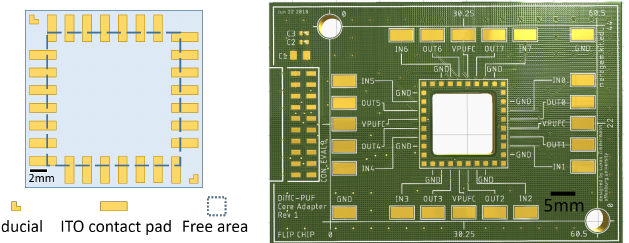
Figure 14. Schematic drawing of the ITO-coated glass and adapter PCB.